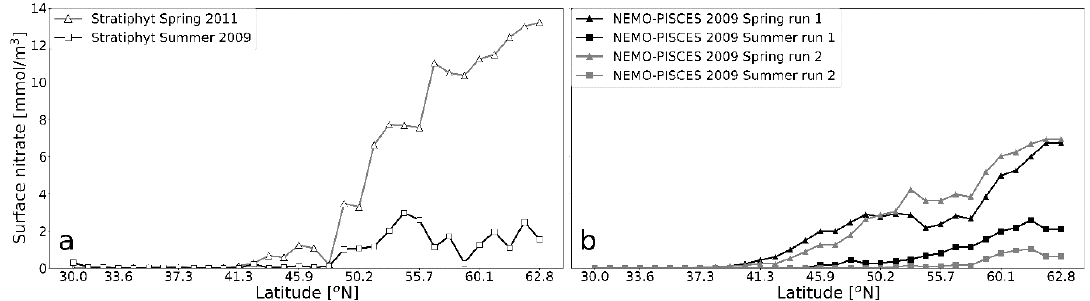
Figure 6. Surface nitrate concentrations (upper 15 m) of Stratiphyt ( a ) and NEMO-PISCES (nucleus for European modelling of the ocean - pelagic interactions scheme for carbon and ecosystem studies) run 1 and 2 ( b ) during spring and summer. Model results are April–May (2011) and July–August (2009) averages.